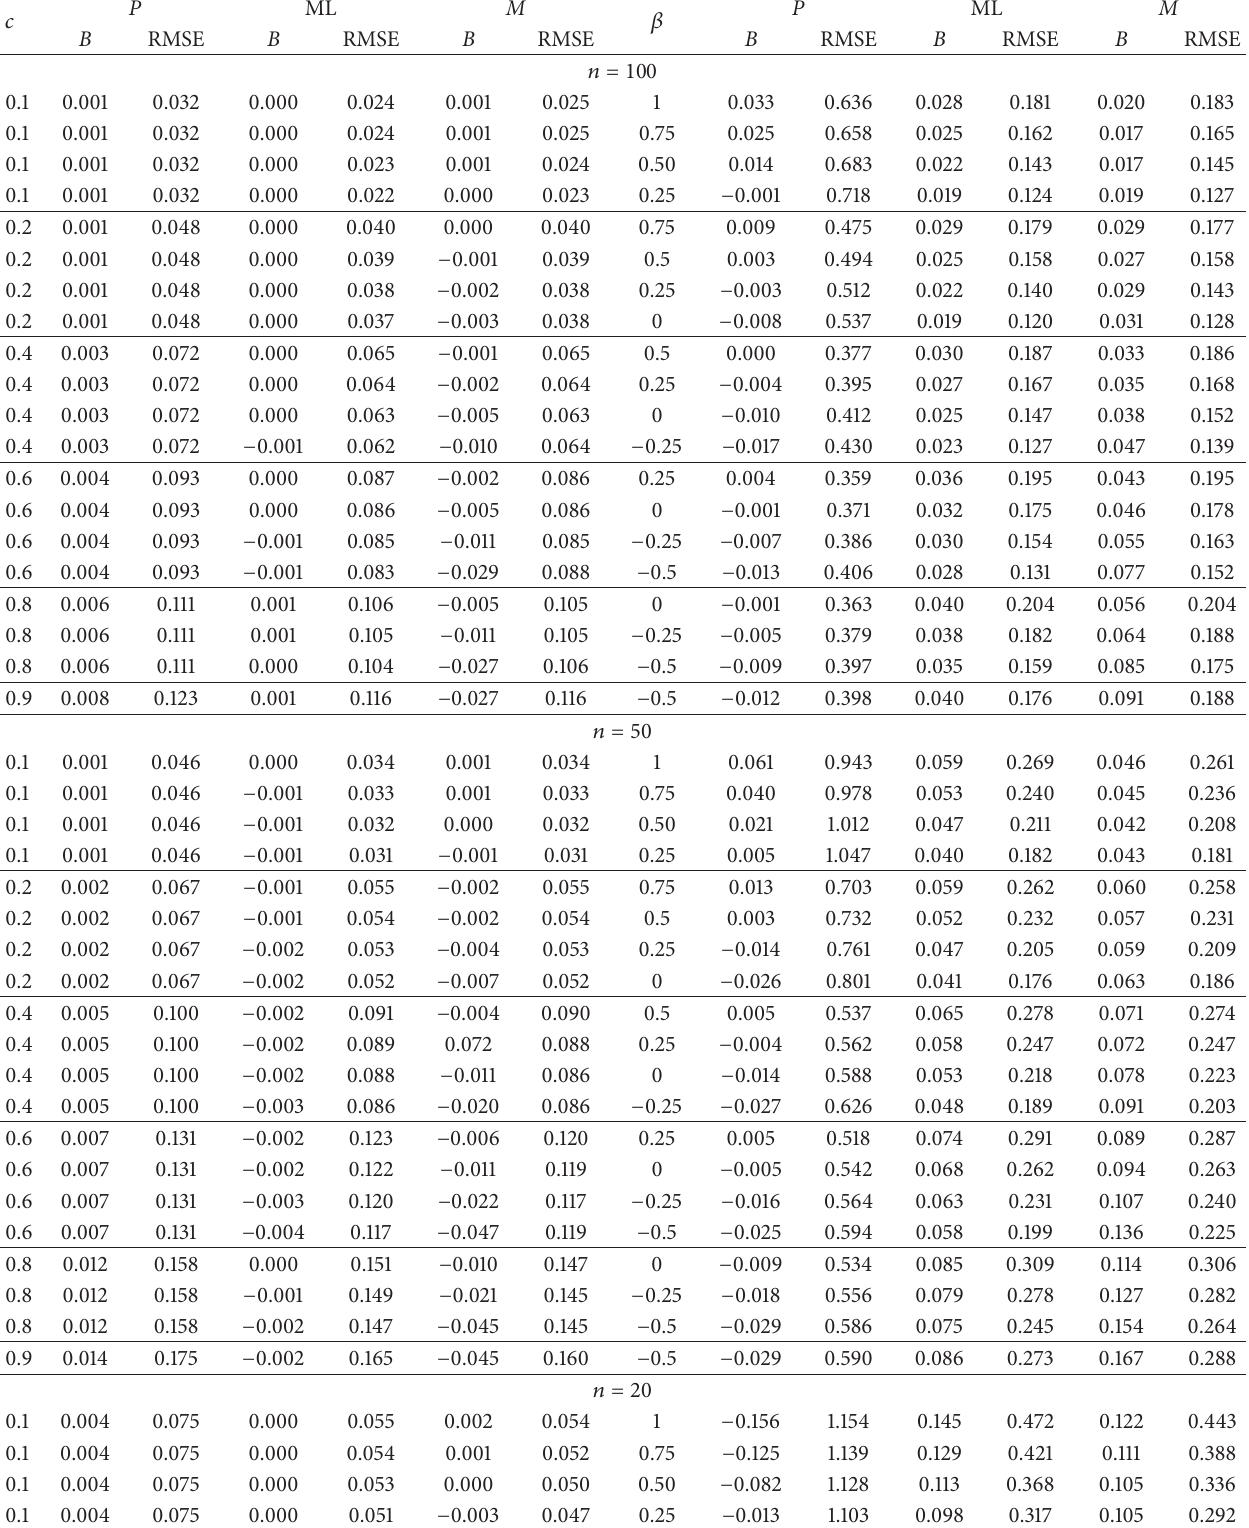
Table 2: Simulation results: bias ( B ) and root mean square error (RMSE) for the estimators of 𝑐 and 𝛽